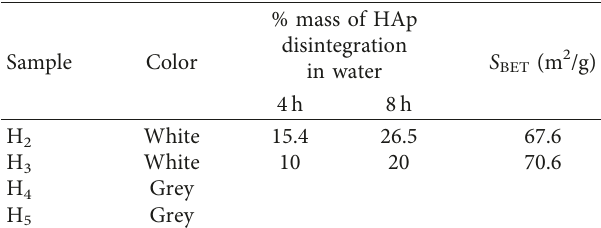
Figure 1: TGA curves of (a) HAp powder and (b) PVA. Table 1: The color, durability in water, and specific surface area of HAp granules sintered at 600 ° C for